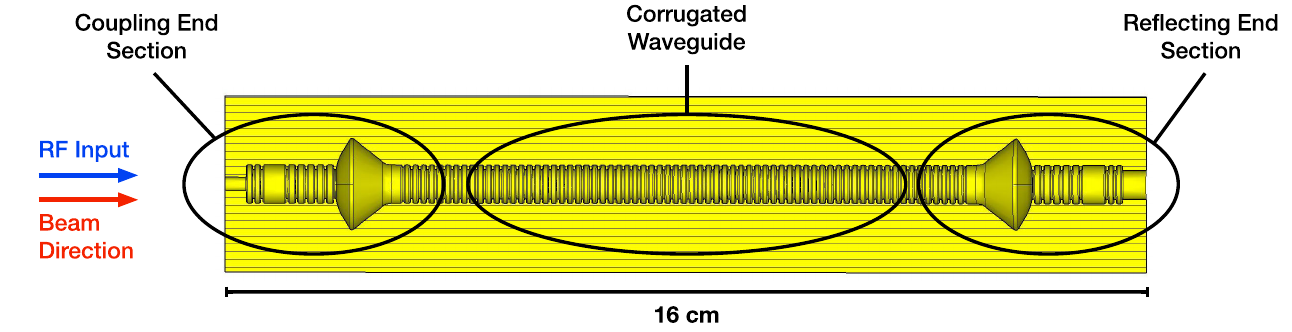
FIG. 2. Millimeter-wave undulator cavity.